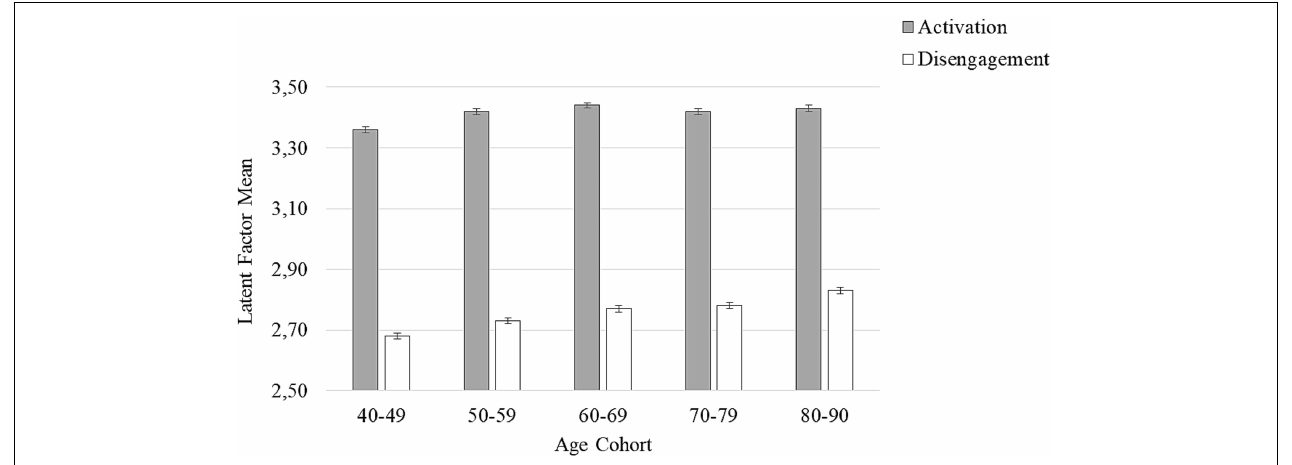
FIGURE 1 | Latent factor means for activation and disengagement by age cohort (40–49, 50–59, 60–69, 70–79, and 80–90 years old), whiskers denote ± 1 SE ( N = 2,862).